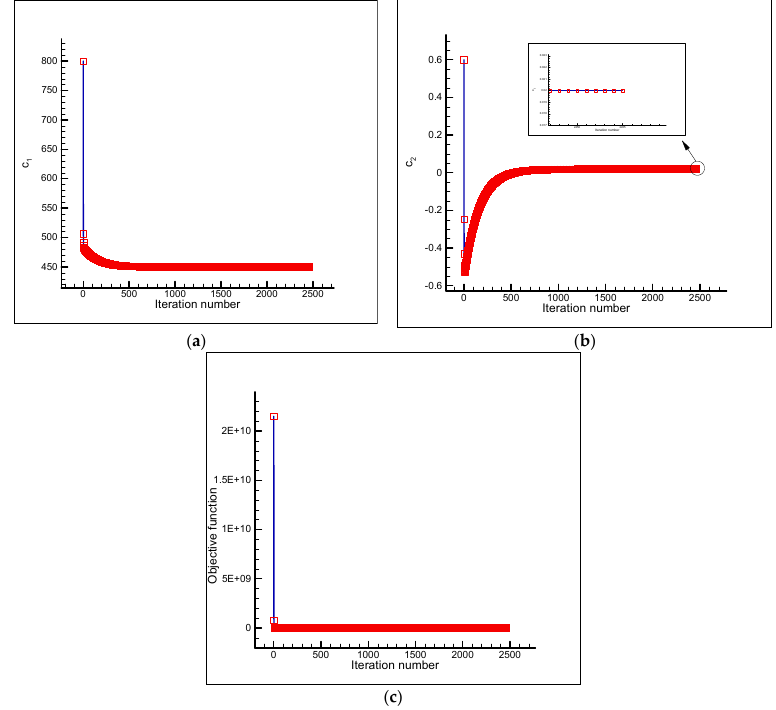
Figure 8. Estimation of c 1 ( a ) and c 2 ( b ), and the objective function versus iteration number ( c ) using ) and a single sensor placed at the node ( i , j ) = ( 3,12 ) the initial guess c initial 2 = 800.0 + 0.6 T ( J kg. ◦ C